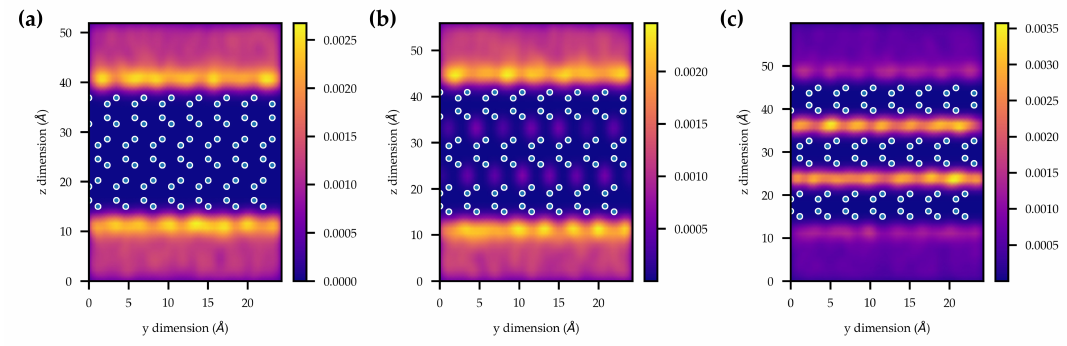
Figure 5. H 2 density “heatmaps” created using kernel density estimation from grand canonical Monte Carlo (GCMC) simulations at 20 bar. ( a ) Pristine γ -InSe. ( b ) γ -InSe with the vdW gaps increased by 2 Å. ( c ) γ -InSe with the vdW gaps increased by 4 Å. The open circles represent the In and Se atomic positions.